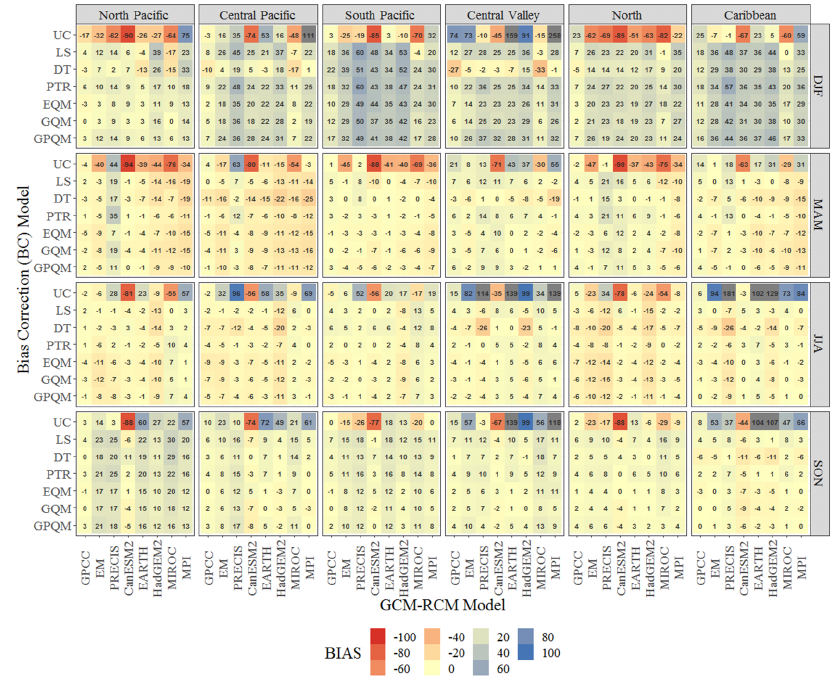
Figure 9. Spatially-averaged percentage bias (PBIAS) performance of uncorrected and bias-corrected precipitation during the validation period 1981–1995 for all climatic regions of Costa Rica. Scale-color represents the PBIAS absolute percentage change (%) after bias correction. Negative values are presented in grey.